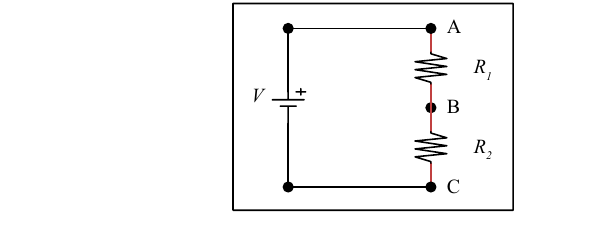
Fig. A4. The Potential difference